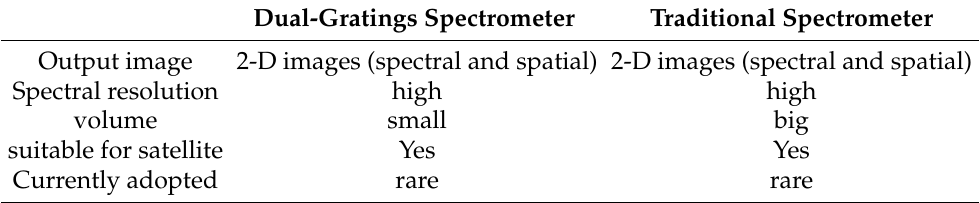
Table 4. Comparison of Traditional imaging spectrometer and Dual-gratings scheme.